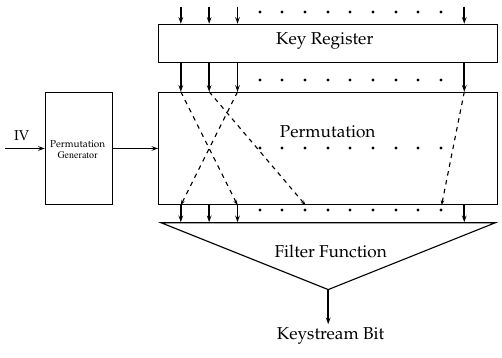
Figure 10: The FLIP stream